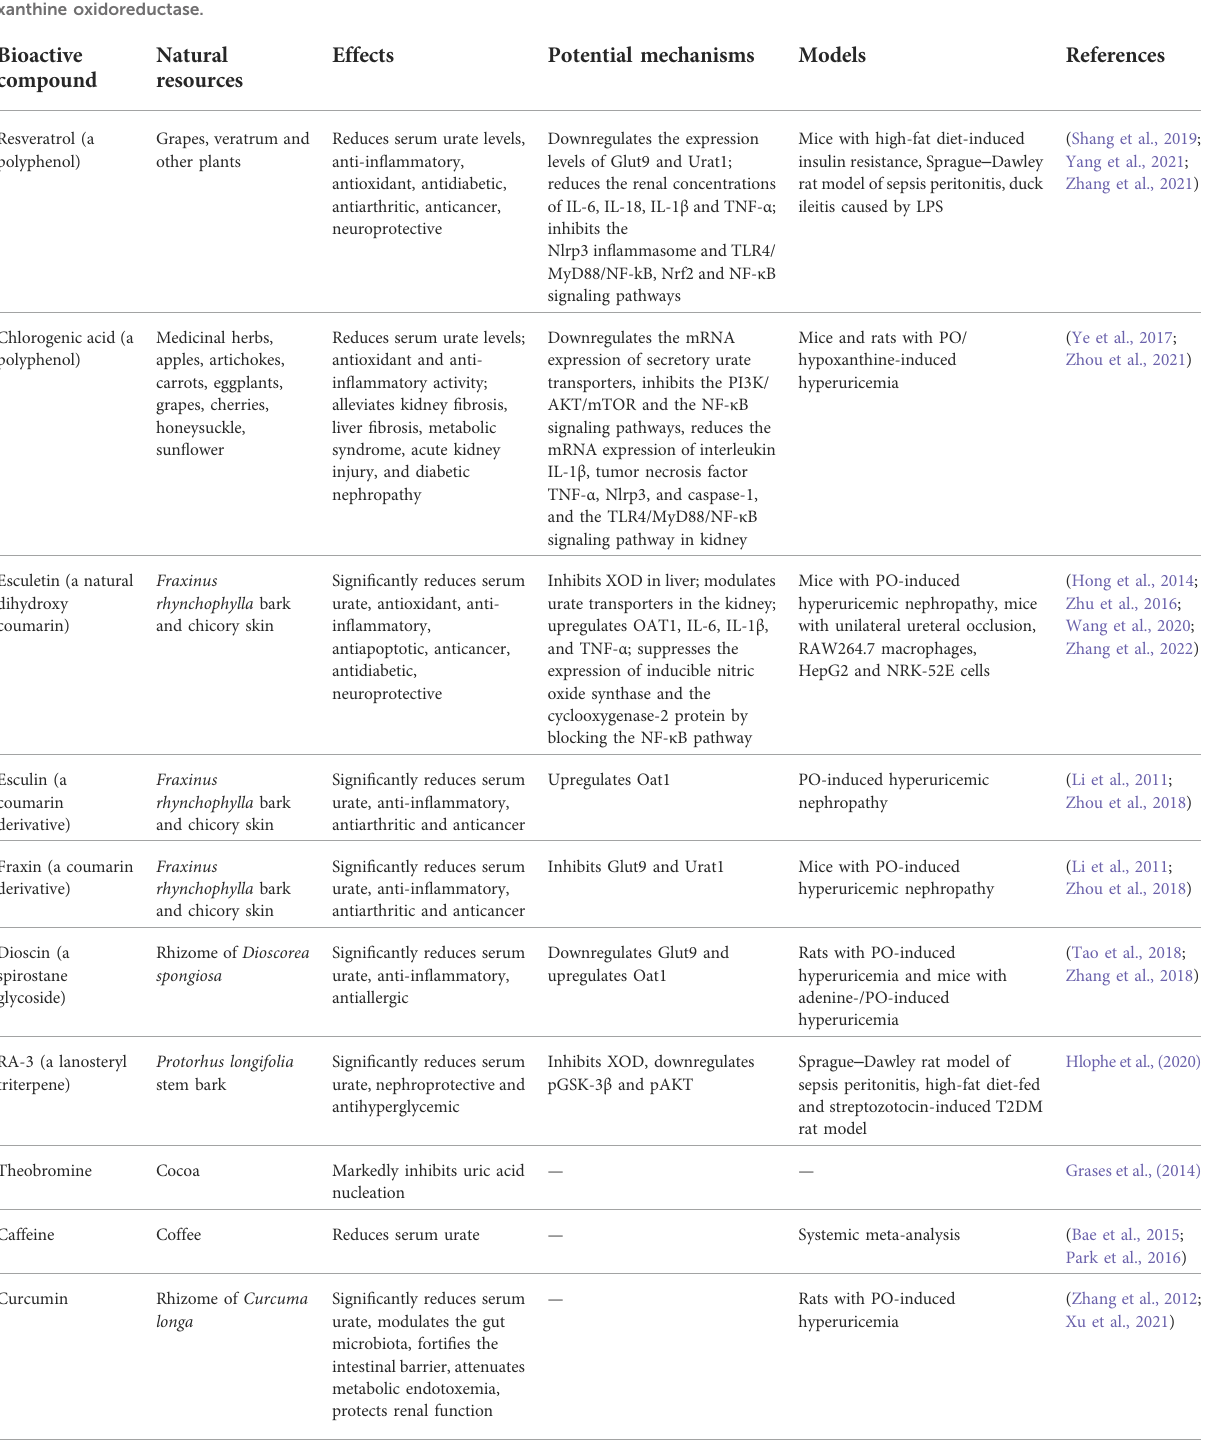
TABLE 1 ( Continued ) Summary of the effects and potential mechanisms of candidates for hyperuricemia treatment. PO, potassium oxonate; LPS, lipopolysaccharide; URAT1, humanuratetransporter1; GLUT9, glucosetransporter member9;ABCG2, ATP-bindingcassettetransporter,subfamily